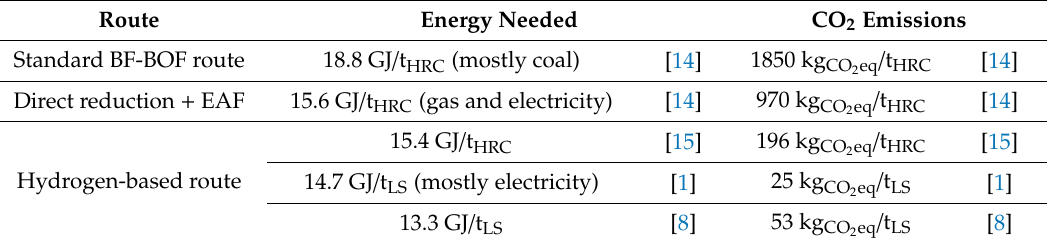
Table 1. Energy and CO 2 emissions of various steelmaking routes.